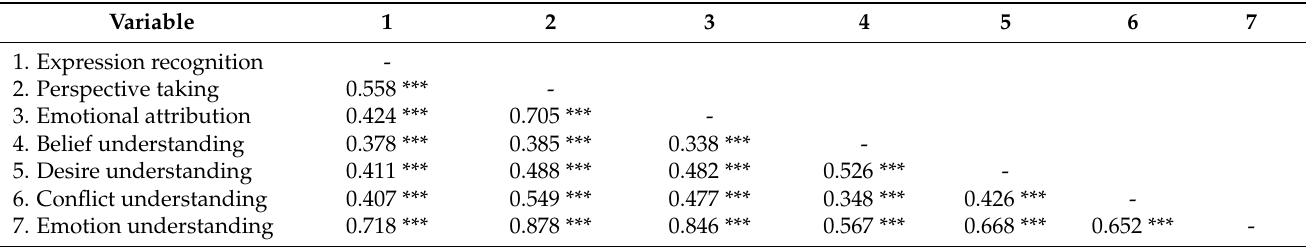
Table 2. Correlation analysis of emotional